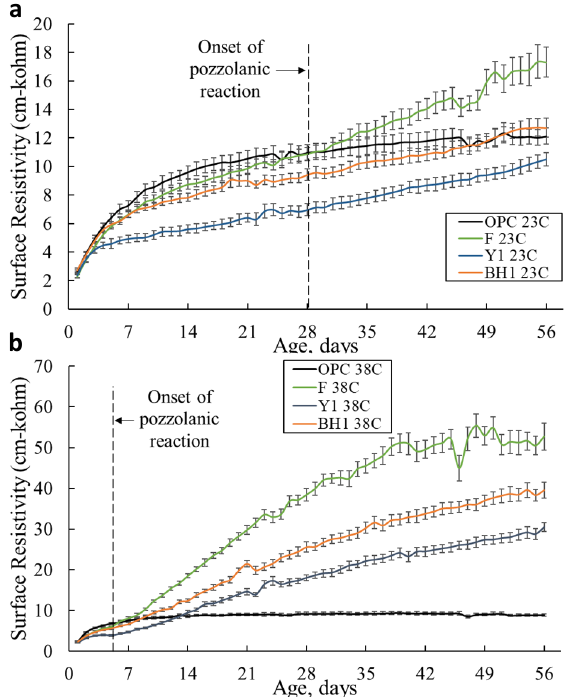
Figure 8. Time series surface resistivity data for four concrete blends at two curing regimes: (a) 23°C and (b) 38°C with estimated onsets of pozzolanic reactions. The blends had a 20% cement weight replacement by the candidate fly ashes. F is an ASTM C618 Class F fly ash, and Y1 and BH1 are off ‐ spec fly ashes that are reclaimed from ash